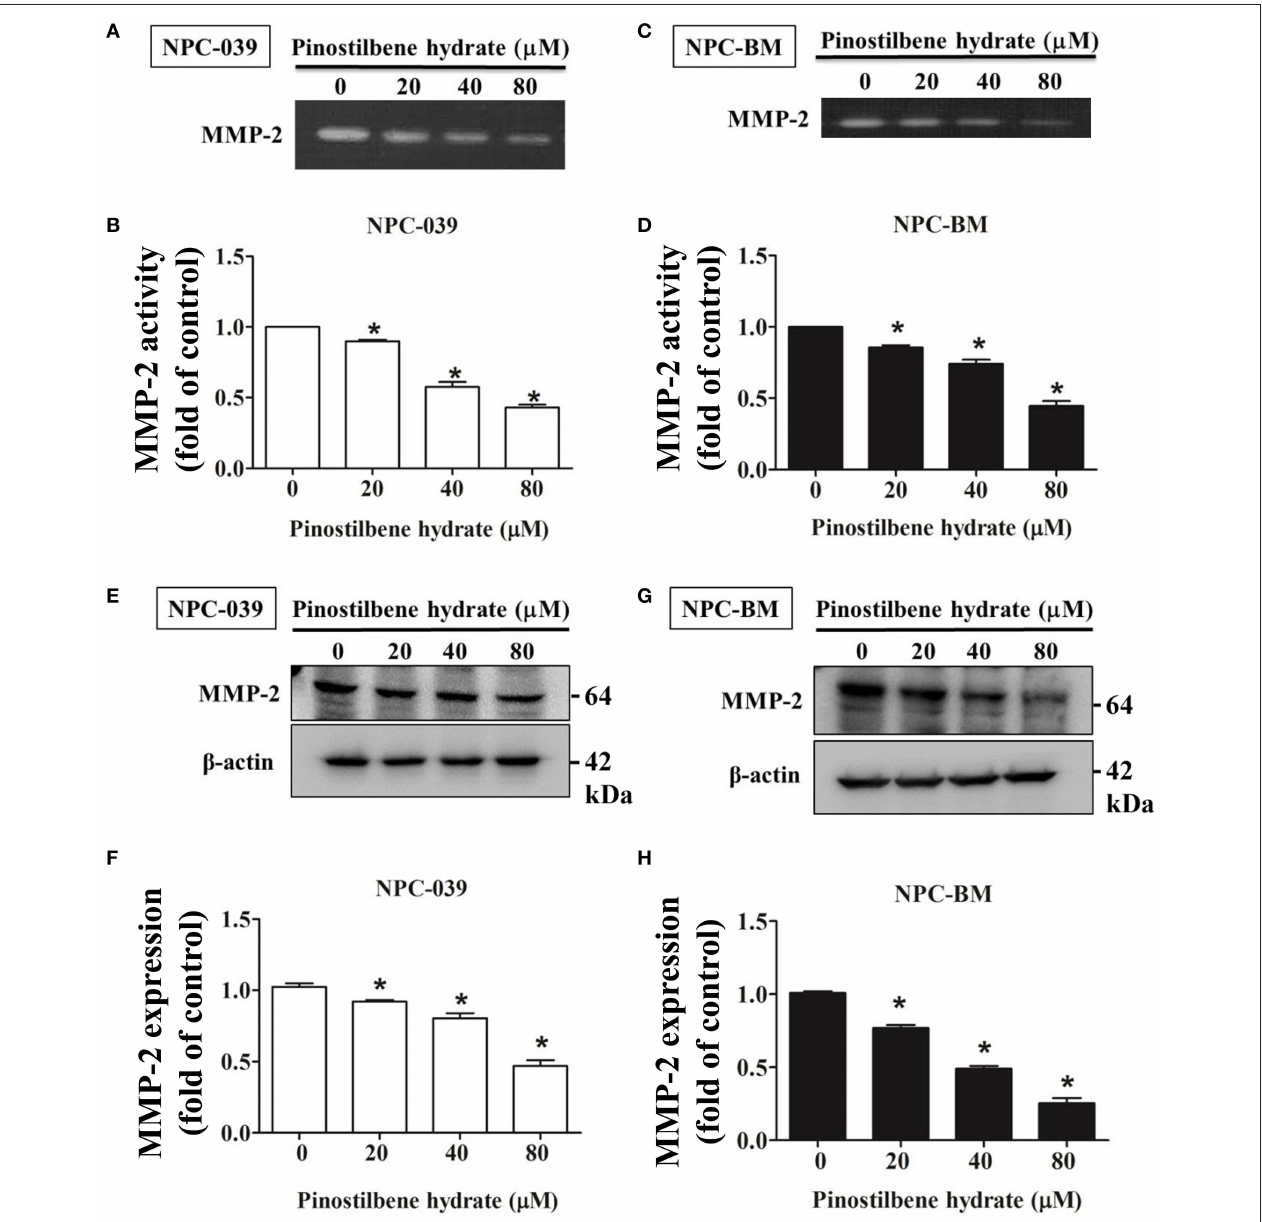
FIGURE 3 | PSH downregulated the activity and expression of MMP-2 in NPC cells. The activity of MMP-2 in PSH treated human NPC cells was examined by the gelatin zymography assay. Significant decreased activity of MMP-2 in a dose-dependent manner was noticed on NPC-039 (A,B) and NPC-BM cell lines (C,D) . (E–H) The expression of MMP-2 level was detected by Western blot assay. PSH significantly reduced the expression of MMP-2 in a dose-dependent manner on both cell lines. β -actin was used as a loading control. The values are the mean ± SD of at least three independent experiments. * p < 0.05.